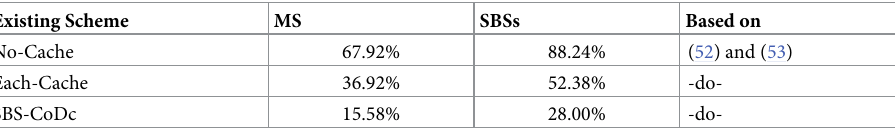
Table 8. Percentage improvement of average SE of MSs and